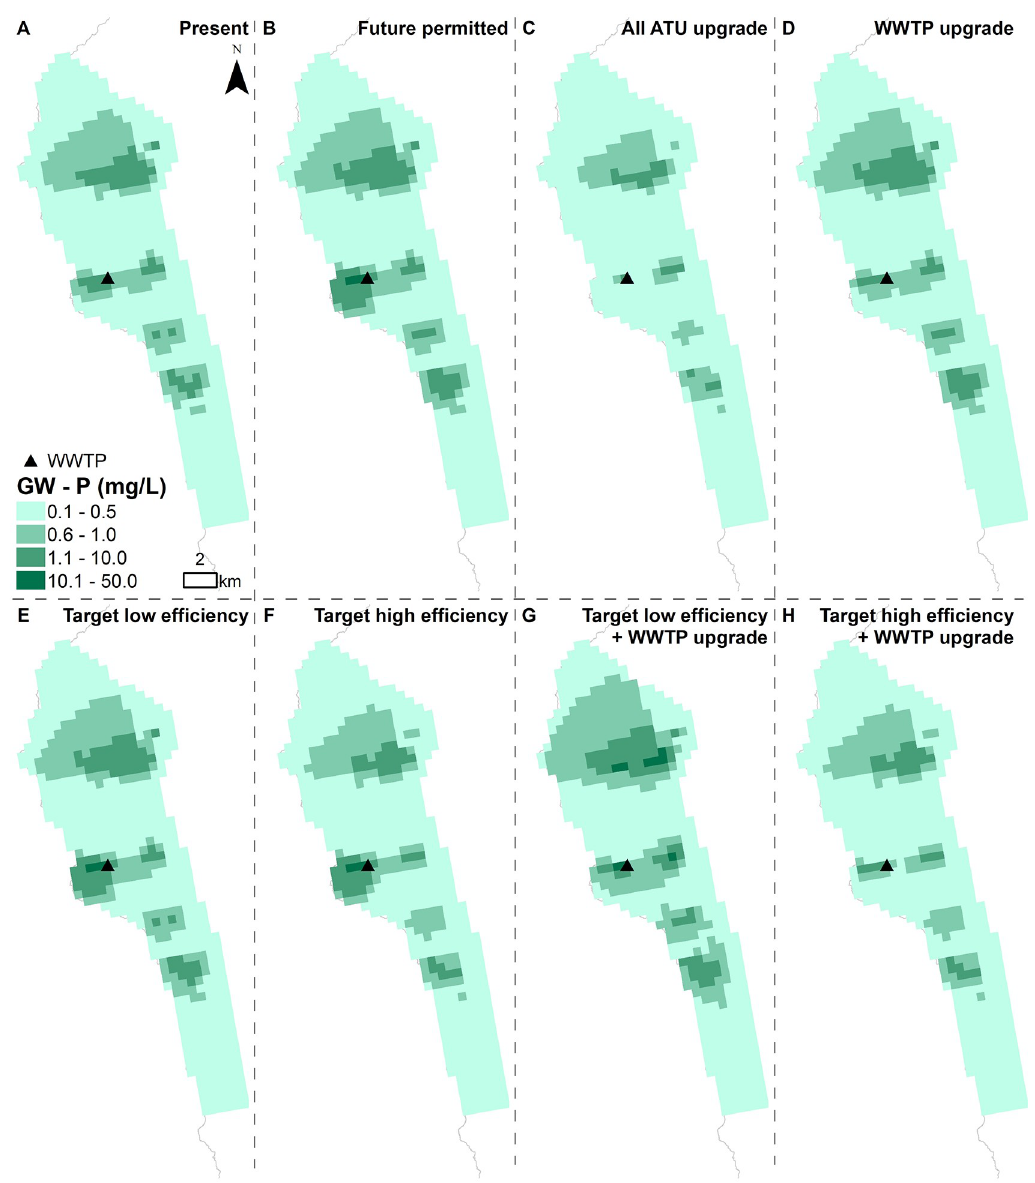
Fig 4. Simulated groundwater P concentrations for (A) current conditions and (B-H) all scenarios. Maps display results from the first layer of the groundwater model, where the bottom of the layer is set to 1 m below mean sea